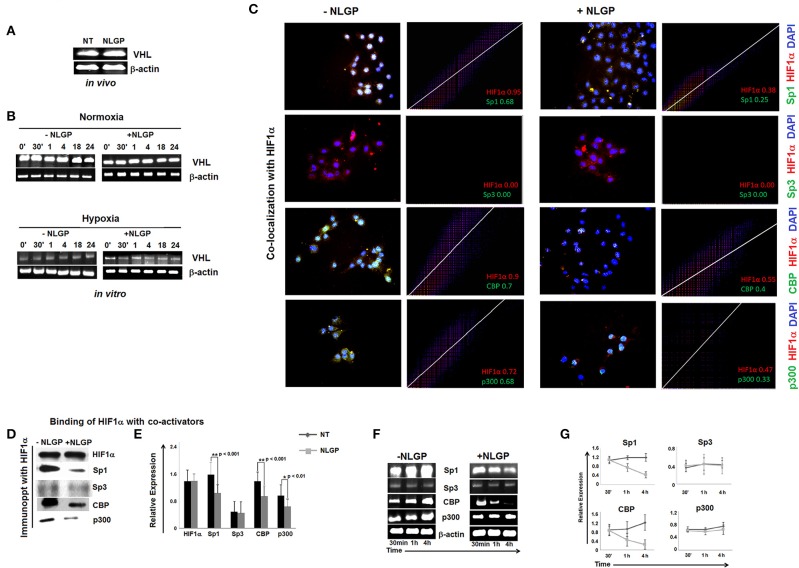
Effect of NLGP on VHL and HIF1α activational co-factors. (A) mRNA expression of tumor suppressor gene, vhl from both in vivo hosts (A) and in vitro B16Mel cells exposed to normoxia and hypoxia at different time points (B), w/wo NLGP, was assessed by RT-PCR. β-actin was used as a loading control in all cases. (C) Co-localization of HIF1α and its co-activators in presence or absence of NLGP in hypoxia were determined by immunofluorescence microscopy and analyzed by Image J software as 2D histogram pictorial. Nuclei were stained with DAPI. HIF1α and co-activators, Sp1, Sp3, CBP, and p300 were detected with anti-mouse PE and anti-rabbit FITC, respectively. Representative data from n = 6 are presented. Mander's tM1 value greater than 0.6 indicates higher co-localization, tM1 value within 0.5–0.6 range indicates moderate co-localization and values below 0.5 indicates weak co-localization. tM1 values for each co-factors are mentioned in respective pictures. (D) Co-immunoprecipitation and western blot analysis of hypoxia (4 h) treated B16Mel cells from w/wo NLGP treatment as indicated. (E) A representative bar diagram showing mean ± SD from n = 6 are presented. (F) Representative data from n = 6 are shown, exhibiting mRNA expression using RT-PCR of sp1, sp3, cbp, and p300 genes in hypoxia w/wo NLGP treatment at 3 different time points (30 min, 1 h, and 4 h). β-actin was used as a loading control. (G) A line diagram showing mean + SD (n = 6) representing change in expression with NLGP treatment form untreated samples are shown for three different time points (30 min, 1 h, and 4 h) of hypoxic condition.